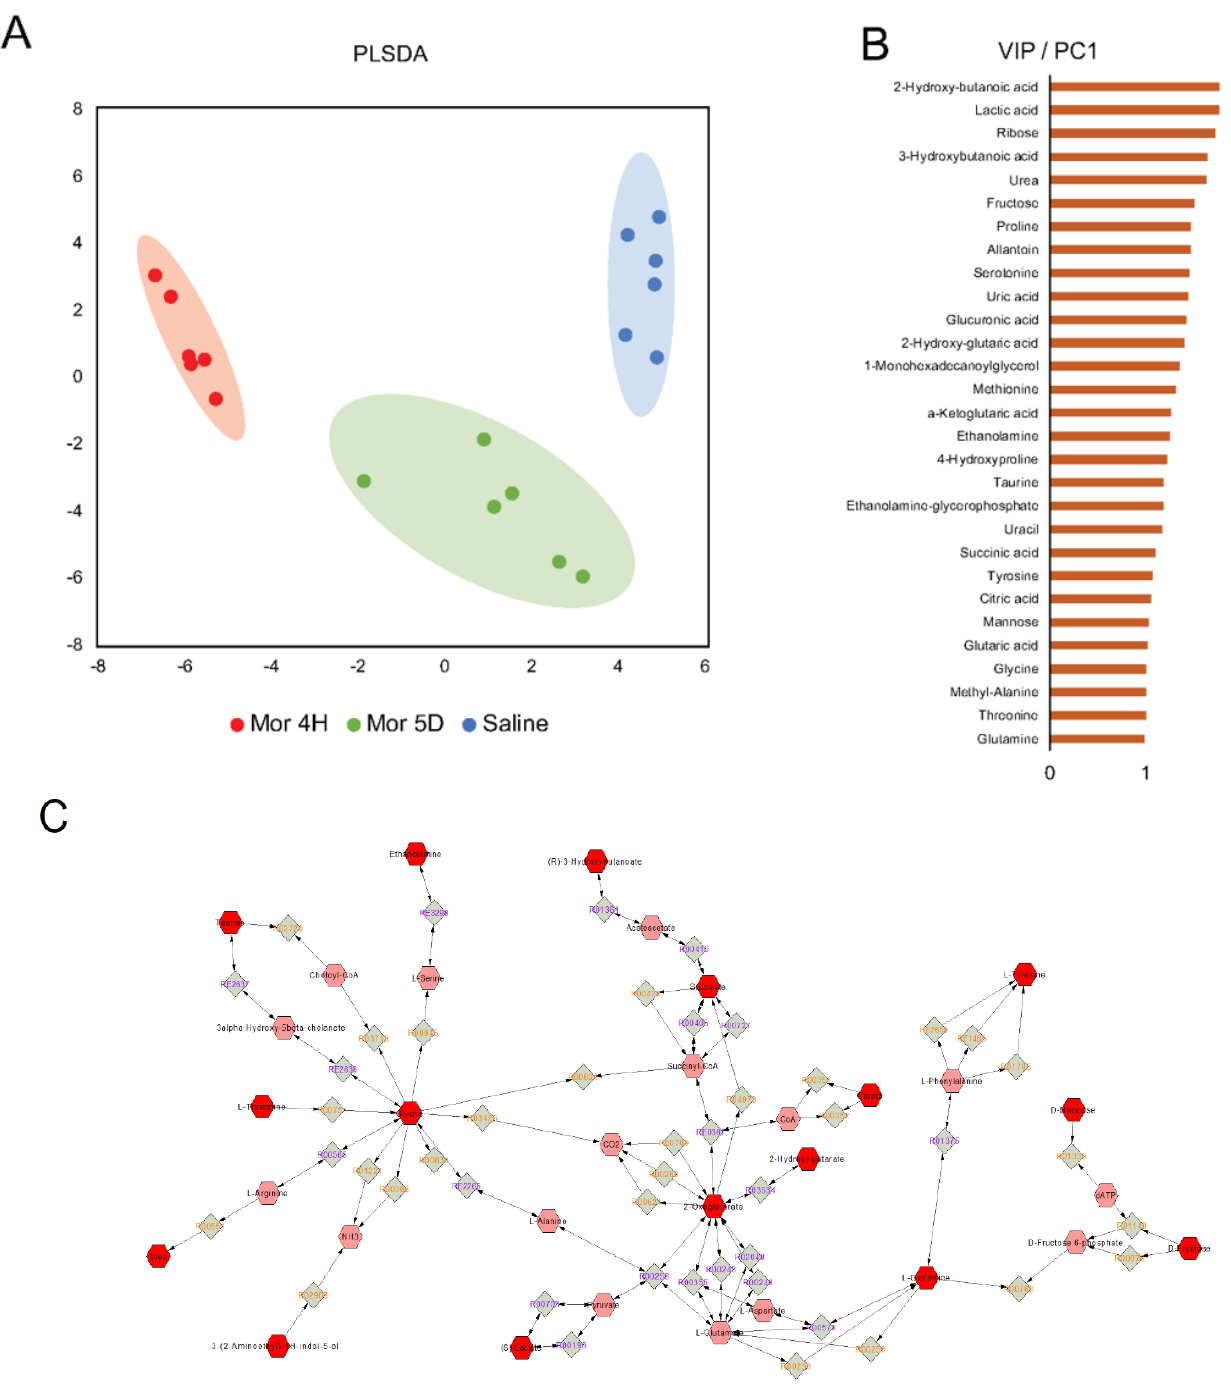
Figure 3. Metabolic network analysis of the first 30 metabolites, ranked according to the VIP score on PLSDA PC1, responsible for changes in metabolite plasma concentrations in the 4H, 5D, and Saline groups. ( A ) PLSDA dimensionality reduction of metabolic profiles to PC1 and PC2; ( B ) VIP scores as projected on PC1 for first 30-ranked metabolites; ( C ) metabolic network reconstruction analysis showing four main networks centered on amino acid, TCA cycle, and glycolytic metabolism. Red nodes represent metabolites among the first 30-ranked features according to VIP scores, edges represent metabolic enzymes responsible for metabolite biotransformations, and orange nodes represent metabolites not reported among the first 30 ranked VIP ones but involved in their biotransformations/metabolism.